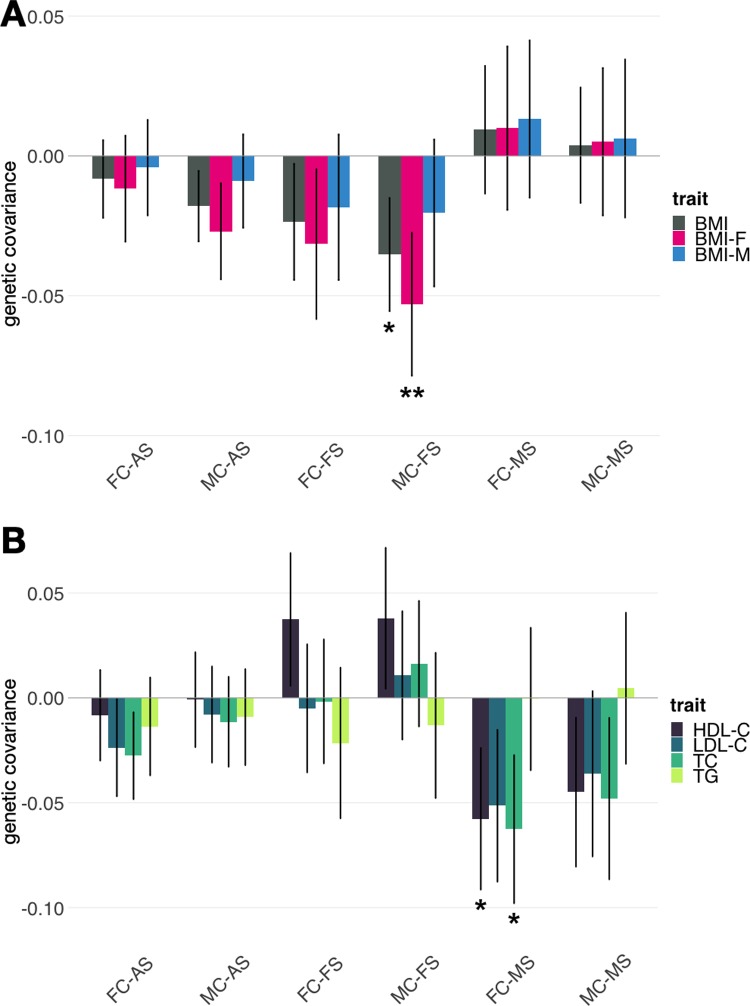
Genetic covariance between facial attractiveness and (A) BMI traits, (B) lipid traits. Intervals show the 95% confidence intervals of covariance estimates. Genetic covariance with fdr < 0.1 are marked by one asterisk and the covariance with p-value < 1e-4 is marked by two asterisks.